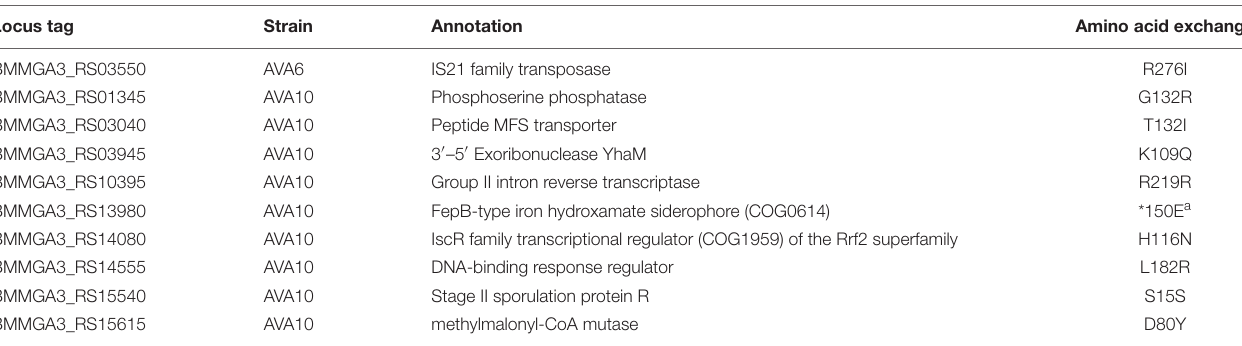
FIGURE 5 | SNPs determined by whole-genome sequencing of B. methanolicus WT, AVA6, and AVA10 (A) and predicted protein structures of three key target genes BMMGA3_RS03040 (B) , BMMGA3_RS13980 (C) , and BMMGA3_RS14080 (D) comprising respective SNPs in AVA10. Isolated genomic DNA of B. methanolicus strains WT, AVA6, and AVA10 were sequenced, and SNPs in all CDSs of B. methanolicus were detected. (A) Venn diagram for observed SNPs. Gene loci were abbreviated such that the leading “BMMGA3_RS” was cut, leaving a five-digit identifier. Optional tailing numbers in brackets indicate multiple SNPs. Yellow identifiers refer to SNPs in genes coding for ribosomal RNA, and blue and red identifiers highlight SNPs in upregulated and downregulated genes, respectively, according to the differential RNA-Seq analysis. (B–D) 3D protein models were predicted using Phyre2 (Kelley et al., 2015). Selected SNPs resulting in amino acid exchanges are highlighted in red. Intergenic mutations found in AVA6 and AVA10 are described in Table 4 . TABLE 3 | Gene loci with SNPs in B. methanolicus ALE strains AVA6 and AVA10. Locus